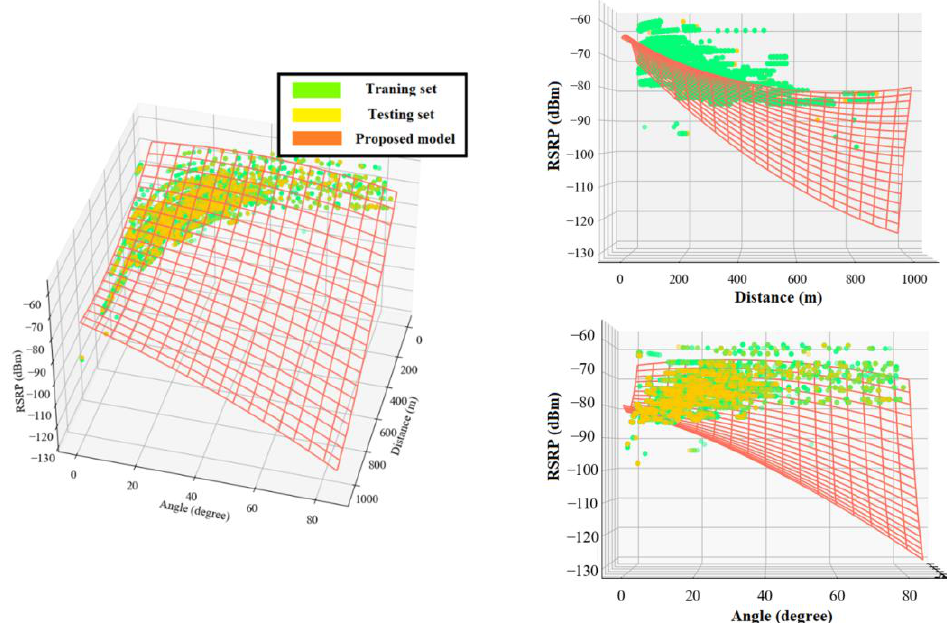
Figure 13. 3D representation of the proposed polynomial model for RSRP.